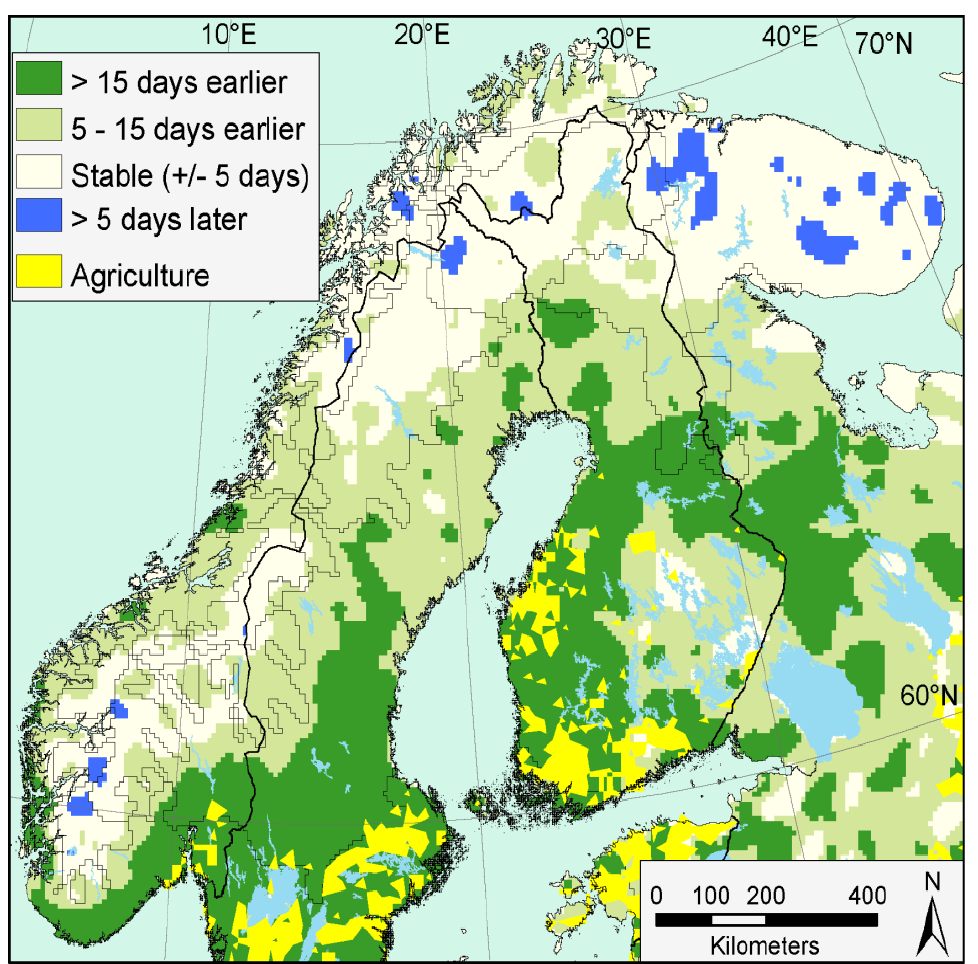
Figure 3. Number of days of the earlier start of growing season in Fennoscandia in 2011 compared to 1982 assuming a linear trend. Black line, national borders; grey line, vegetation region borders (see Figure